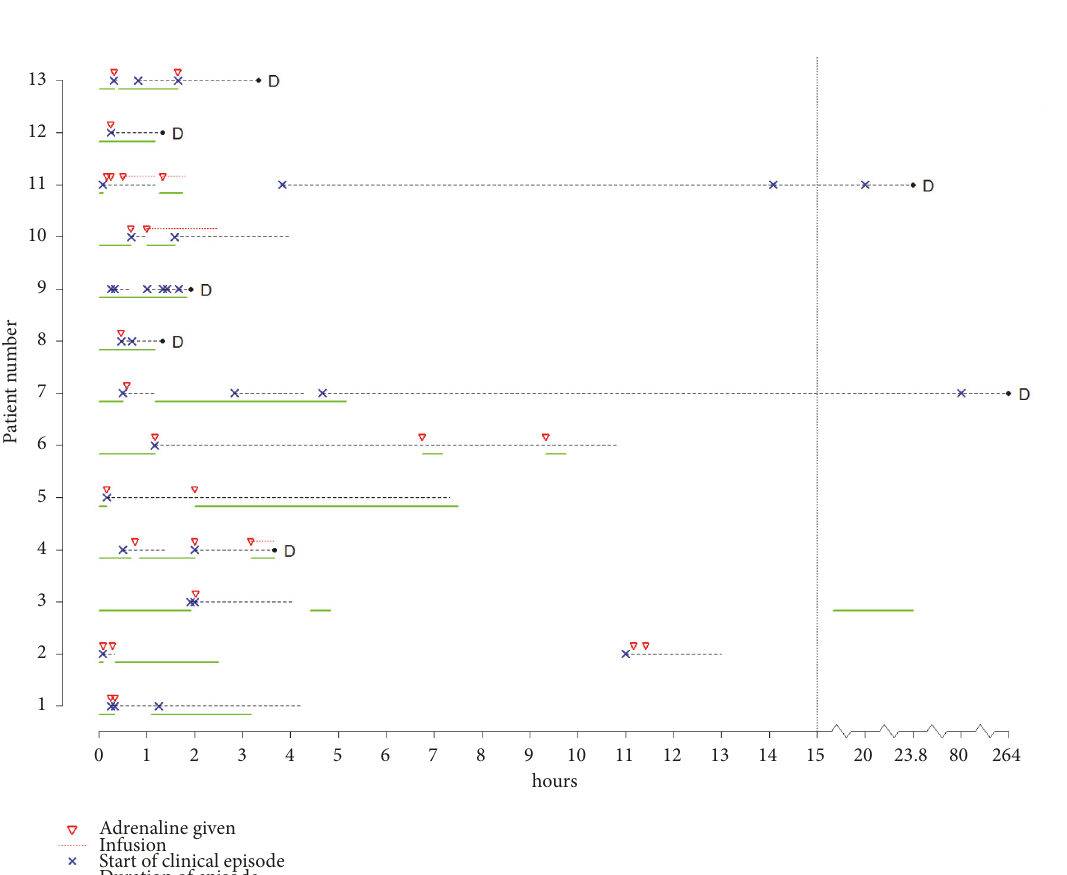
Figure 2: Time course of antivenom administrations, clinical events, and adrenaline treatment. Time 0 is the start of antivenom administra-